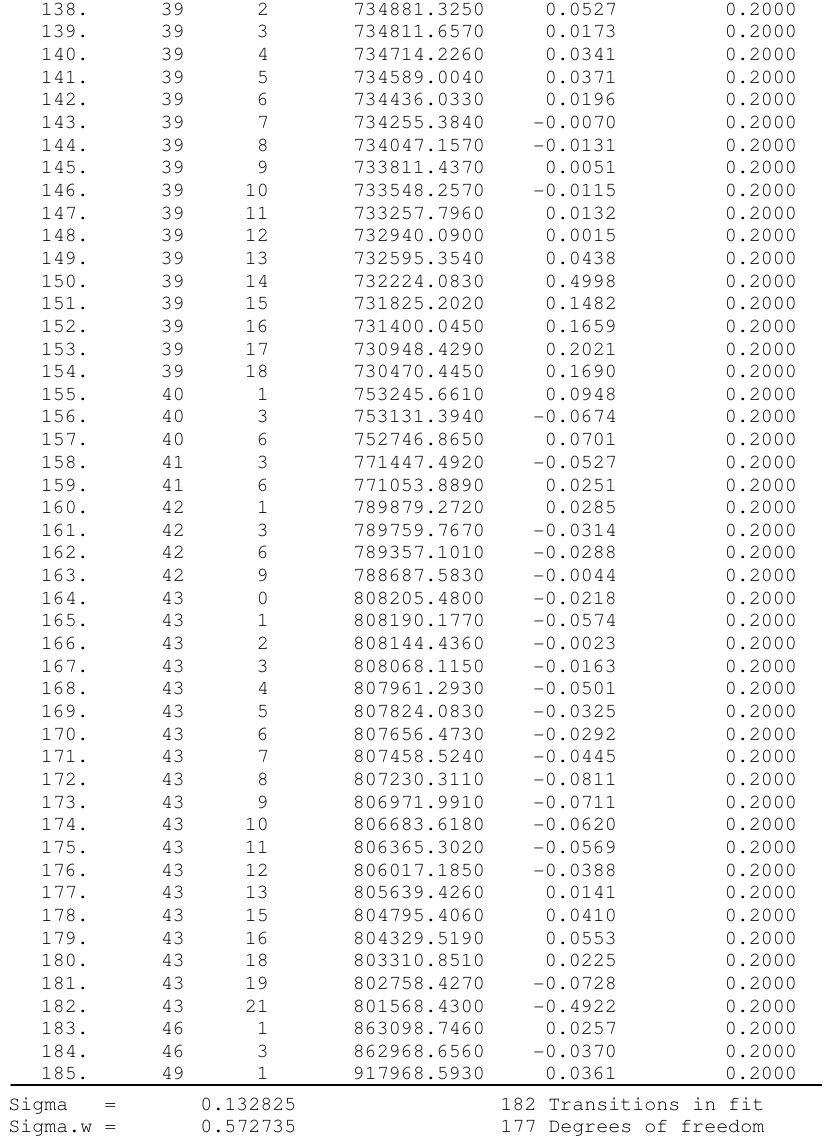
Table 2. Correlation coefficients of CH